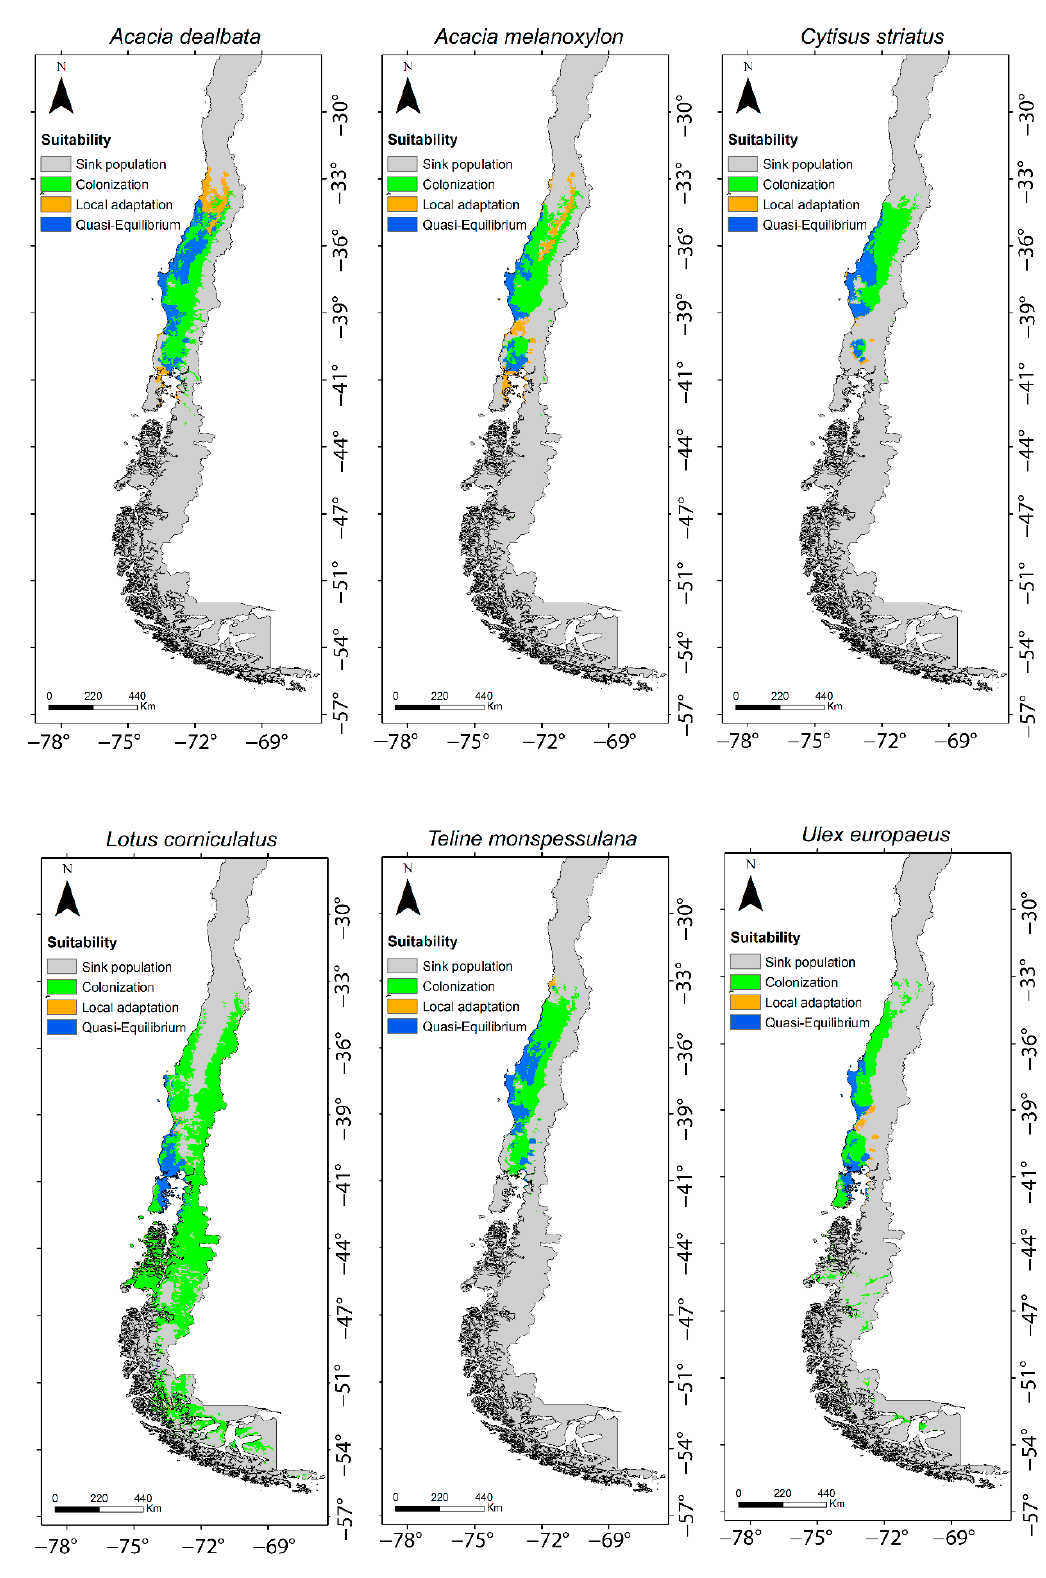
Figure 3. Areas of different invasive stages predicted by SDMs for the six study species. Gray represents predicted area for sink stage; green represents area for colonization stage; blue represents area for quasi-equilibrium stage; orange represents area for local adaptation stage.